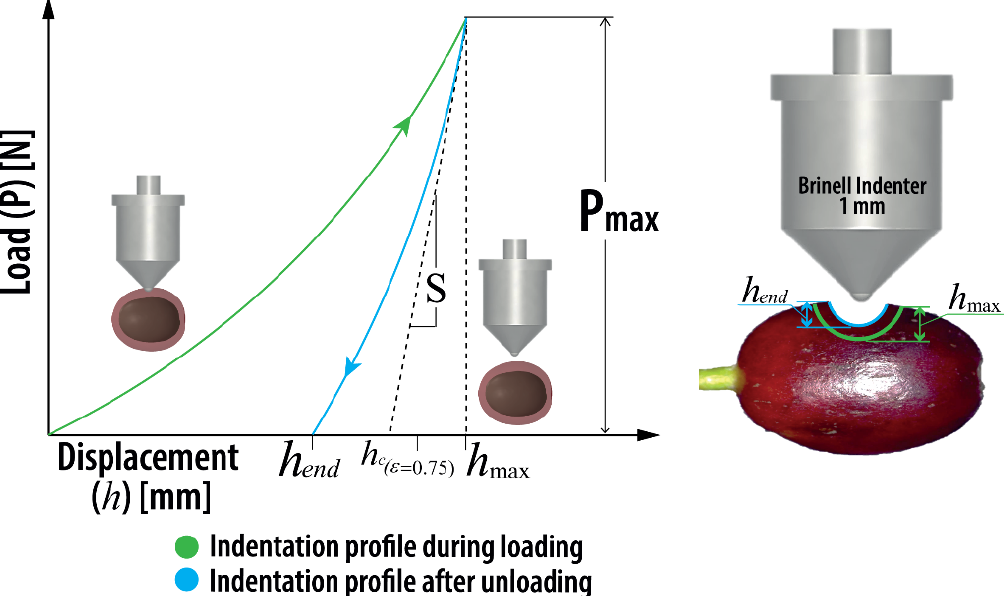
Figure 1. Loading and unloading process on the exocarp–mesocarp of coffee fruit. This relation is obtained from Equation (1). However, this considers the effect of the indenter shape, represented by an empirical indenter shape correction factor parameter ( β = 1 for a spherical indenter). Considering the projection dP / dh (see Figure 1) on the displacement axis, the value of h c is defined as